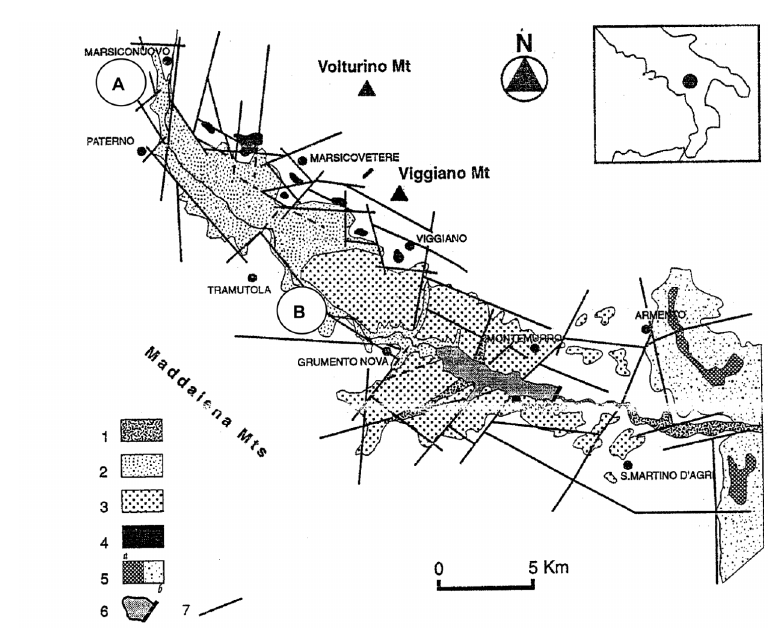
Fig. 1. Structural geological context of the investigated area. The alluvial deposits are shown: recent (1), Holocene–upper Pleistocene (2), upper-middle Pleistocene (3); subaerial slope deposits, upper-middle Pleis- tocene (4); conglomerates and sands, middle-lower Pleistocene (5); Pertusillo Dam (6); faults (7) (Giano et al. , 2000). A: location of the magnetotelluric monitoring station in Marsico Nuovo. B: location of the magnetotel- luric monitoring station in ic fields. MN station measures two components